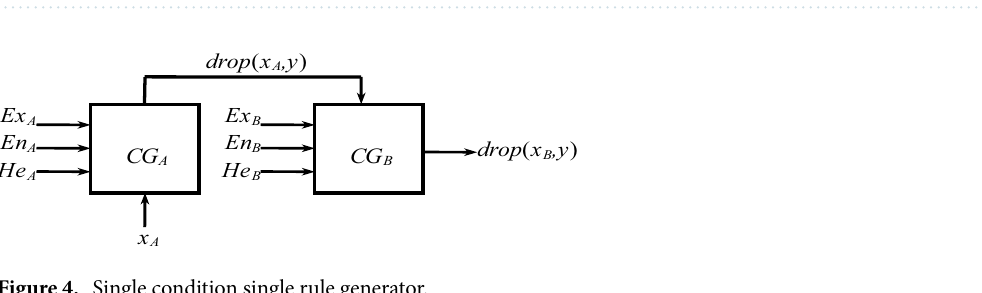
Table 3. The environmental conditions and the development of loess collapsibility of the samples to be evaluated.